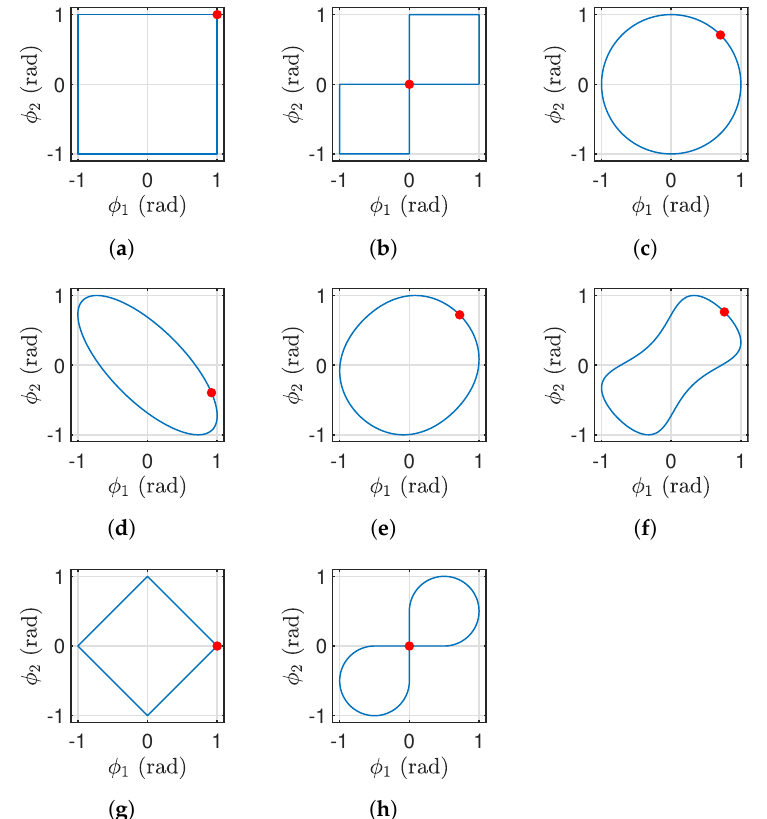
Figure 5. Different gaits applied to the Purcell’s swimmer, with unitary amplitude: ( a ) square ( b ) rectilinear ( c ) circular ( d ) Alouges optimal gait from [19] ( e ) optimal efficiency gait from [21] ( f ) optimal velocity gait from [21] ( g ) diamond gait ( h ) petal gait. The coloured circular mark represents the initial point of the